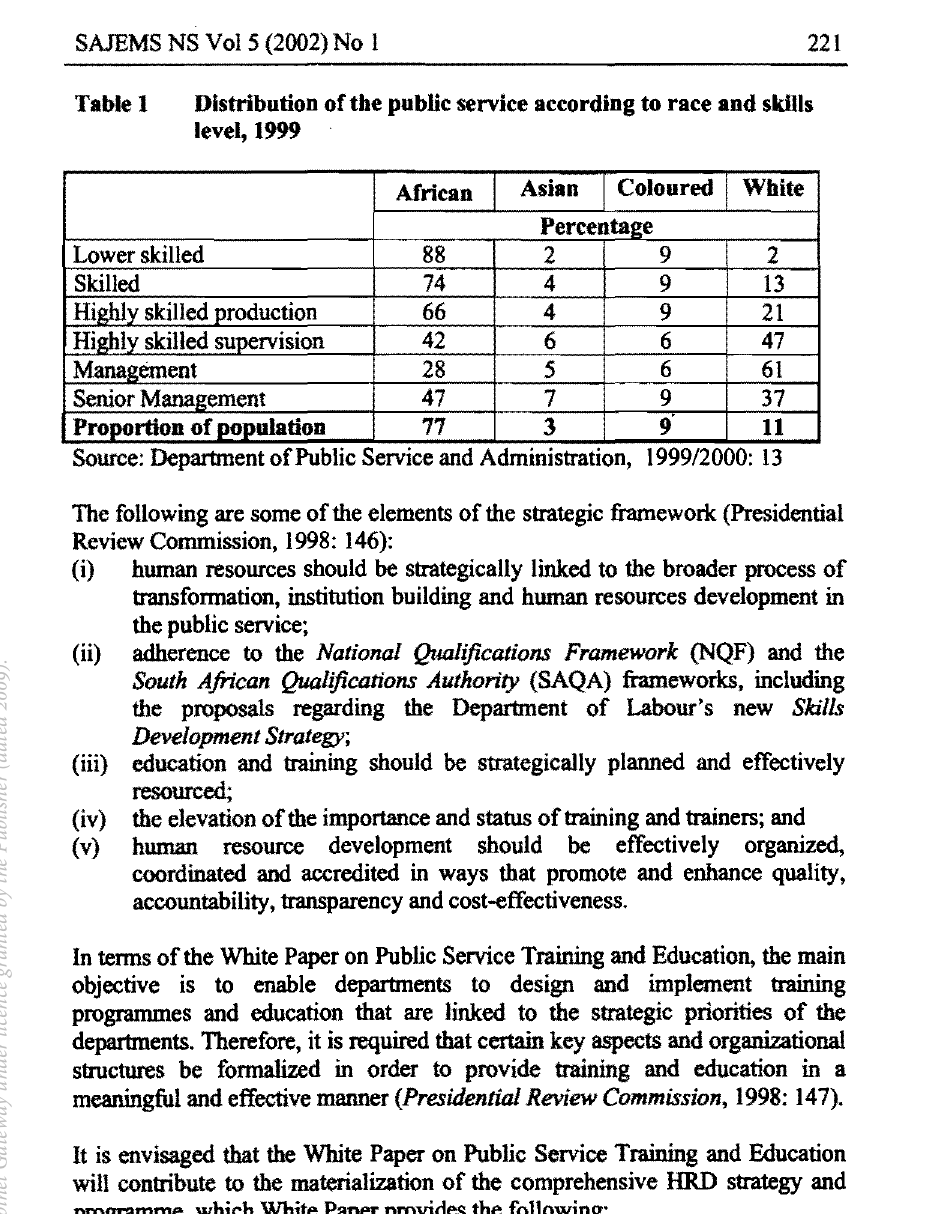
Distribution oftbe public service according to race and skills level,l999 African Asian Coloured Wbite Percenta~e Lower skilled 88 2 9 2 74 4 9